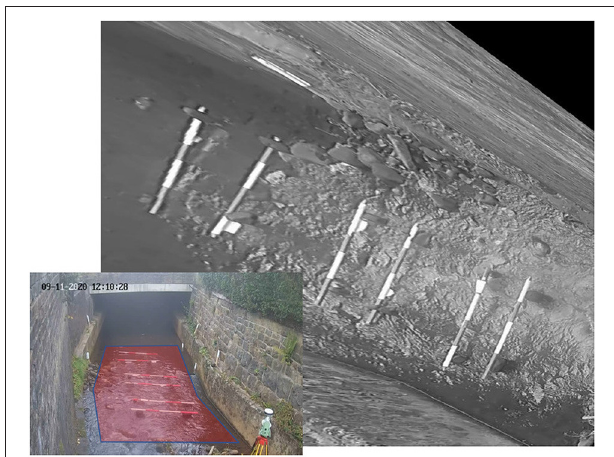
FIGURE 8 | Example of a river surface acquired at Todmorden, UK (bottom left). The red region indicates the region of interest selected by the user. The greyscale image is the orthorectified product produced using